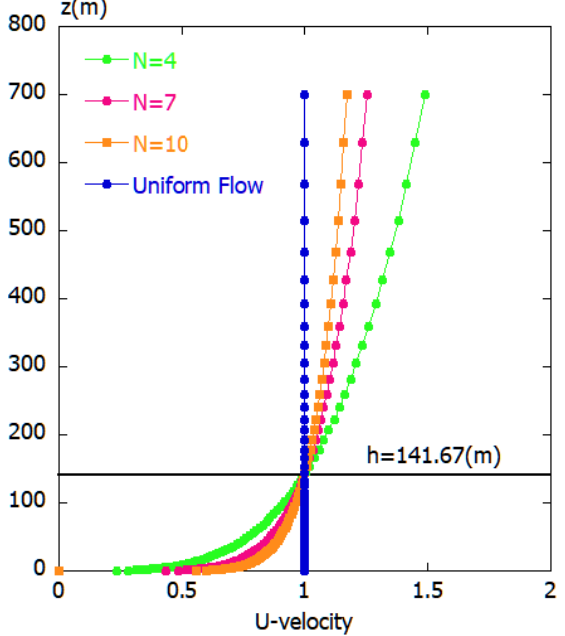
Figure 27. Various inflow shears investigated in this study.